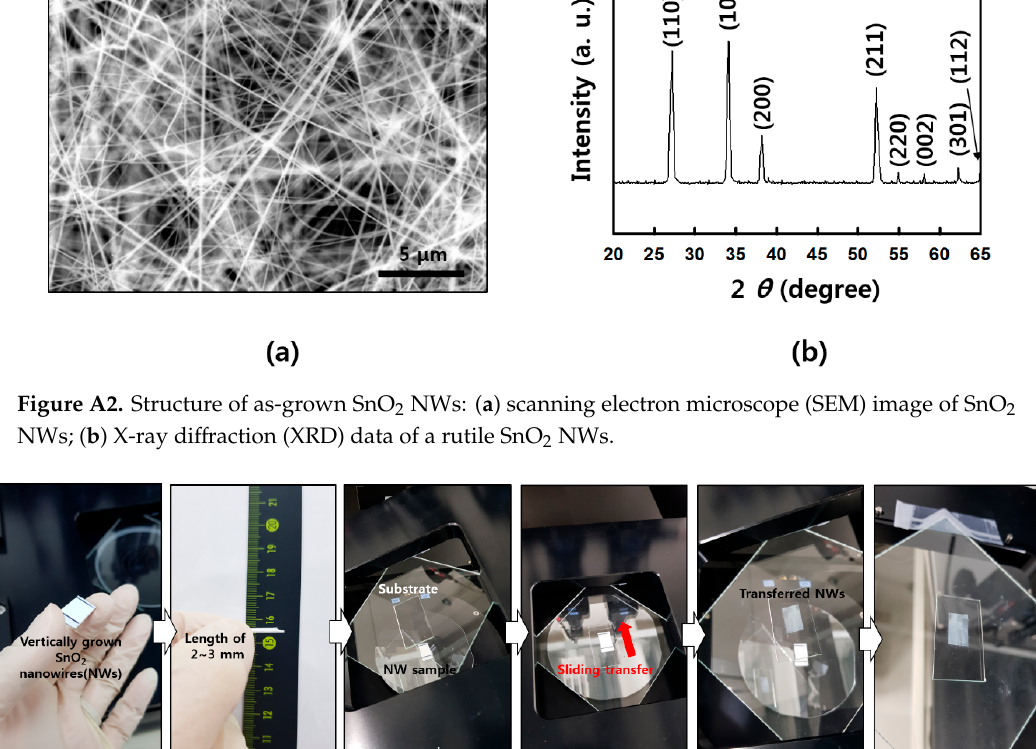
Figure A1. Synthesis procedure of SnO 2 NWs, using CVD system. SnO 2 NWs were grown on Au- deposited Si samples. Samples were loaded inside the Quartz tube with 0.5 g of tin powder in an alumina boat. After raising the temperature of the furnace up to 750 °C, SnO 2 NWs were vertically grown for 30 min.